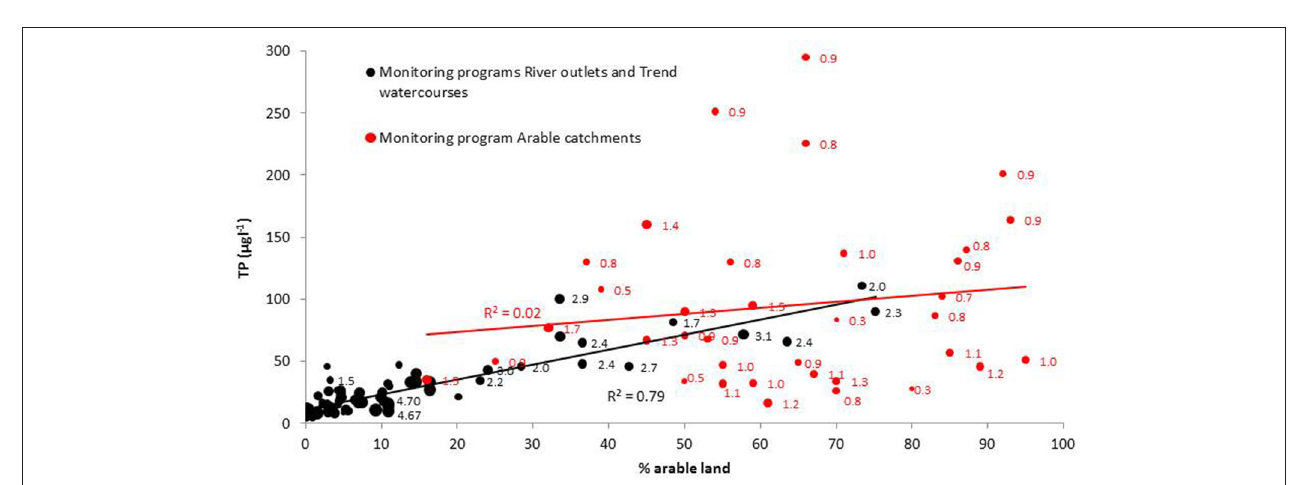
FIGURE 2 | The relationship between the portion of a arable land and median total phosphorus (TP) concentration for the period 2000–2016 included in two Swedish water equality monitoring program: (a) 77 catchments (area 8–50,110 km 2 ). River outlets and trend watercourses (black filled circles) and (b) 36 smaller (area 1.8–54 km 2 ) catchments dominated by agriculture (red filled circles). The size of the filled circles is proportional to the catchment area, and the label value stands for the log 10 area of the catchment (km 2